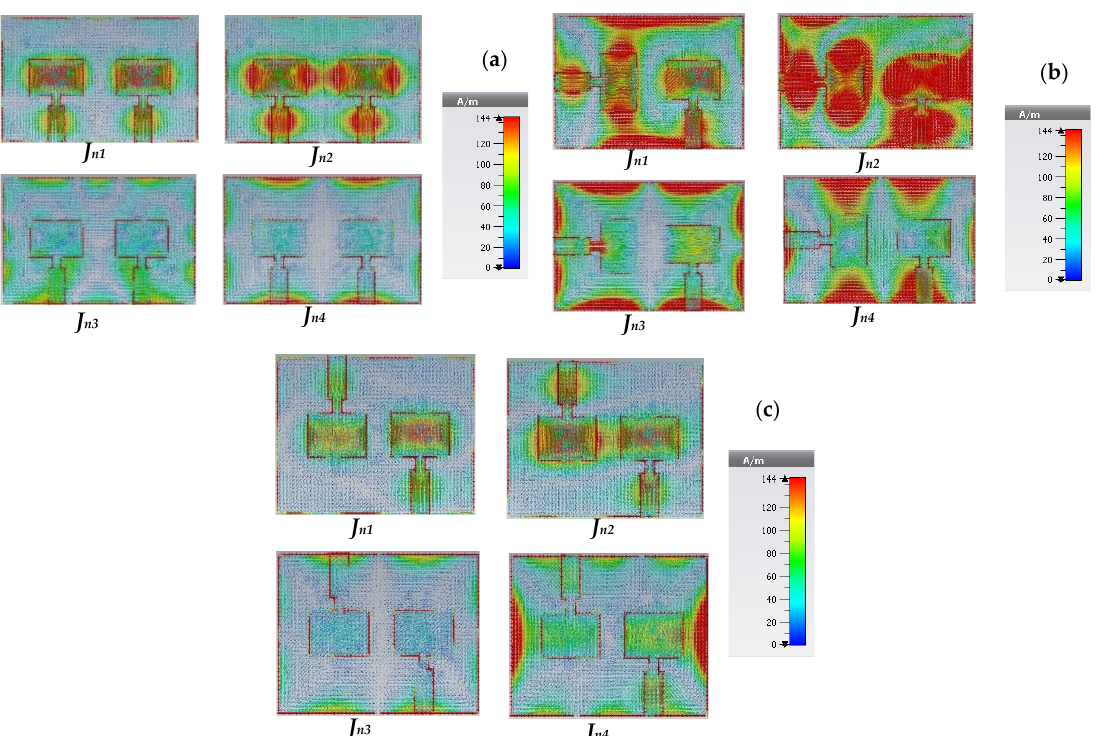
Figure 10. Model Significant of the proposed MIMO configurations ( a ) Ant. A, ( b ) Ant. B, and ( c ) Ant. C .